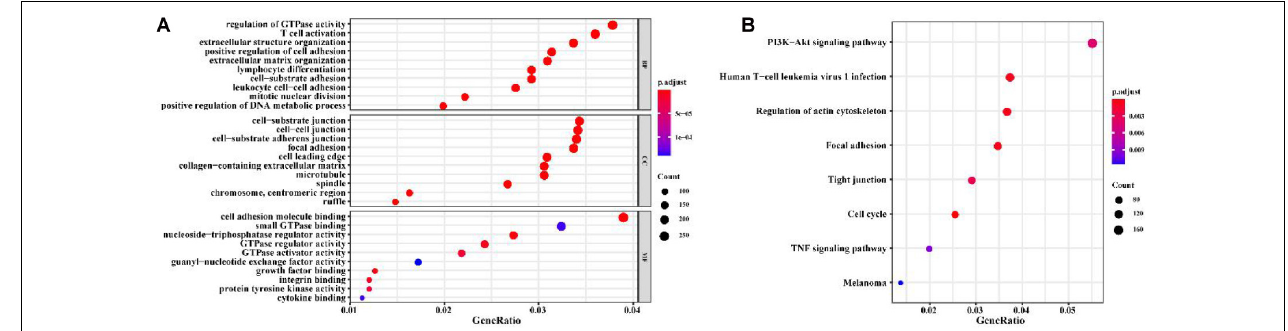
FIGURE 3 | GO and KEGG enrichment analysis for the immune-related lncRNAs co-expressed with prognostic mRNAs in BC. (A) GO enrichment result. (B) KEGG enrichment result. The x -axis represents the ratio of the number of genes enriched in a single GO (or KEGG) term to the total number of genes changed in all GO (or KEGG) terms, and the y -axis represents the GO (or KEGG) terms. The color of the circle indicates the adjusted p value, and the size represents the number of genes enriched in the term or the pathway.